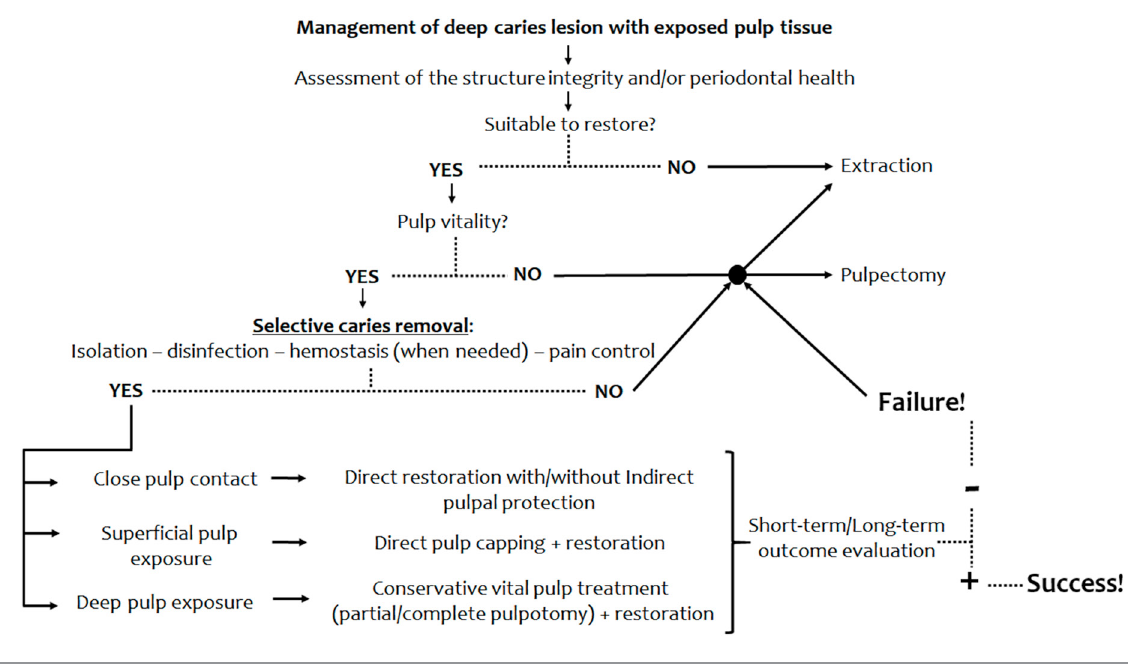
Figure 2. Decision-making flowchart for treatment of deep caries lesions compromising the dental pulp. Strategies for the treatment of primary dentition must be adapted to the patient’s age, their orthodontic and exfoliation status, and the risk of affection of the subjacent permanent